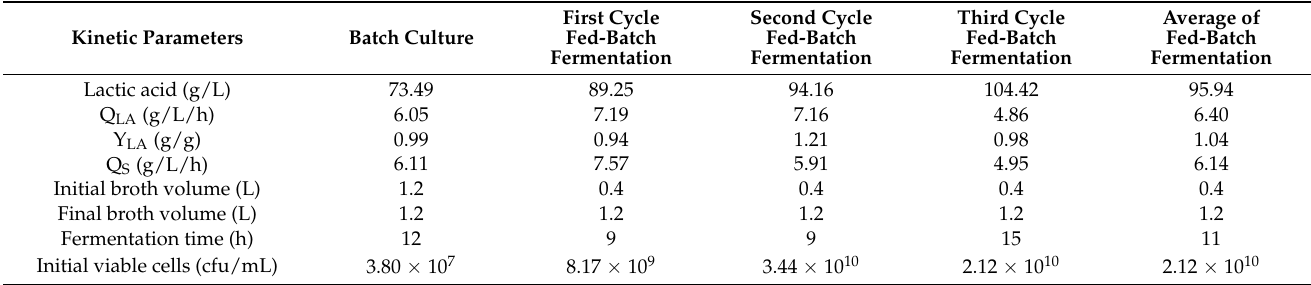
Table 3. Kinetics of fed-batch and repeated fed-batch fermentation of oil palm trunk sap by L. rhamnosus ATCC